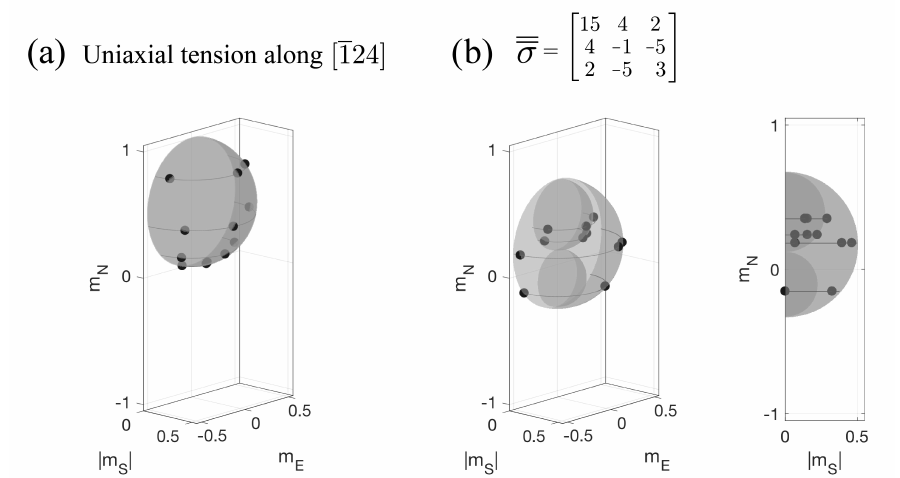
Figure 6. Three-dimensional orientation maps of the Schmid, Escaig and normal factors for ( a ) uniaxial tension along the [ 124 ] direction and ( b ) for an arbitrary stress state after being normalised by the difference between the maximum and minimum principal stresses, as viewed from two directions. The Mohr’s spheres and the semicircles that correspond to the shear stresses on the four slip planes are plotted for